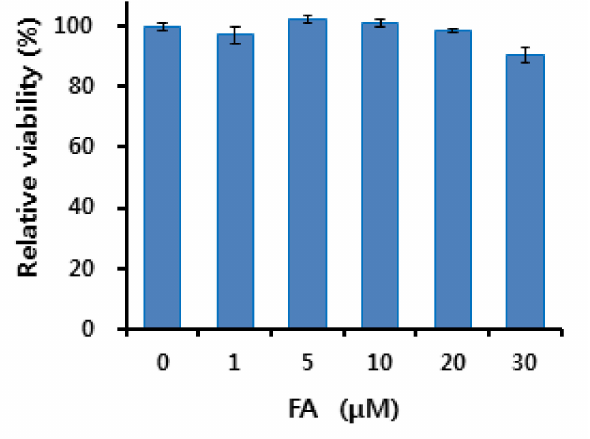
Figure 4. The cytotoxicity of probe EW2 (0–30 µ M) towards MCF7